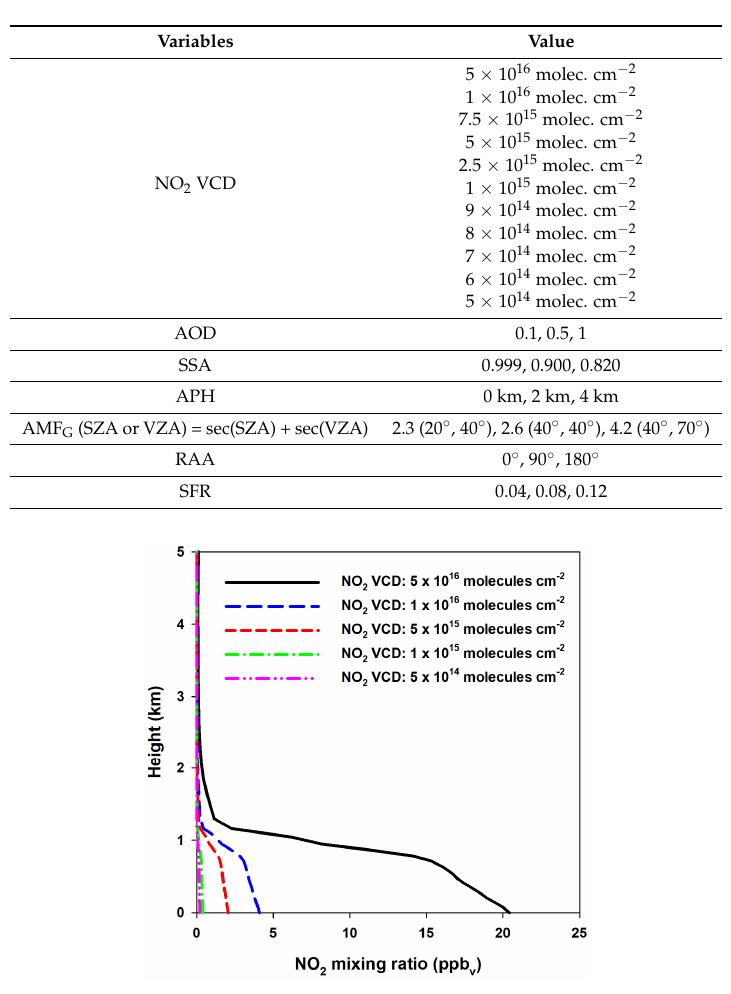
Figure 2. NO 2 mixing ratio profiles as a function of NO 2 vertical column density (VCD) used to calculate synthetic radiances.